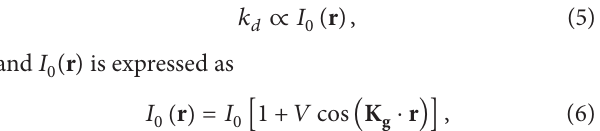
Figure 2: Photopolymer reaction